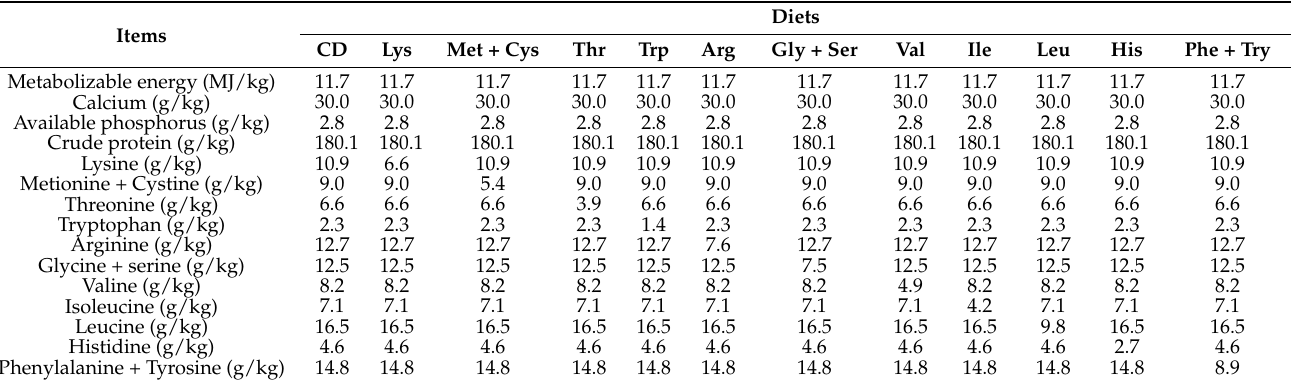
Table 5. Nutritional levels of experimental